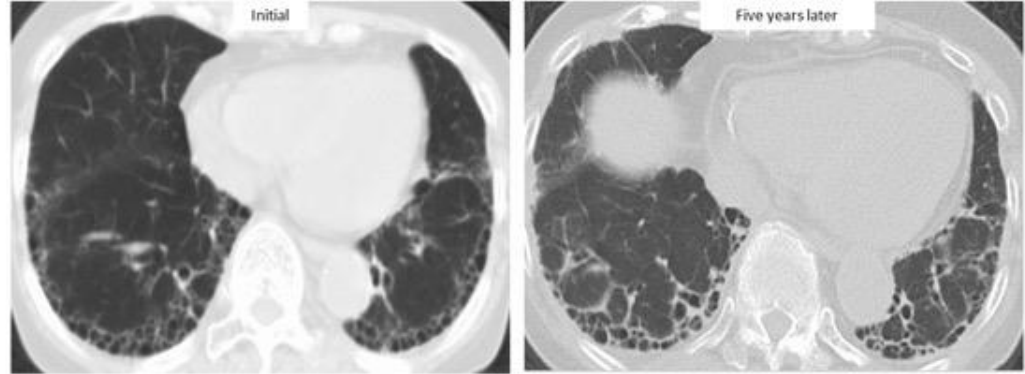
Figure 3. High-resolution computed tomographic images of a patient with a stable course of RA-ILD for five years. 1: Sample bias in the diagnosis of RA-ILD, as this depends on whether a respiratory